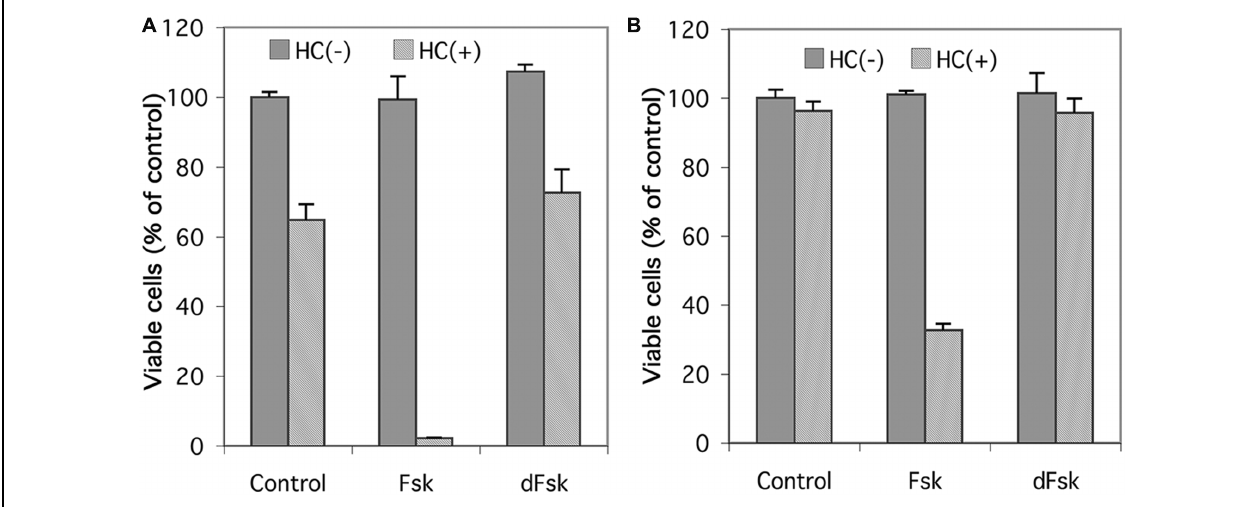
FIGURE 2 | Effect of 1,9-dideoxyforskolin on CEM cells. Cell viability of CEM-S2 cells (A) and CEM-R8 cells (B) . Cells were treated with 10 µ M forskolin (Fsk) or 10 µ M 1,9-dideoxyforskolin (dFsk) in the presence or absence of 10 µ M hydrocortisone (HC) for 72 h. After treatment, cell viability was determined by MTS assay. Data represent the mean ± SD of at least two independent experiments assayed in